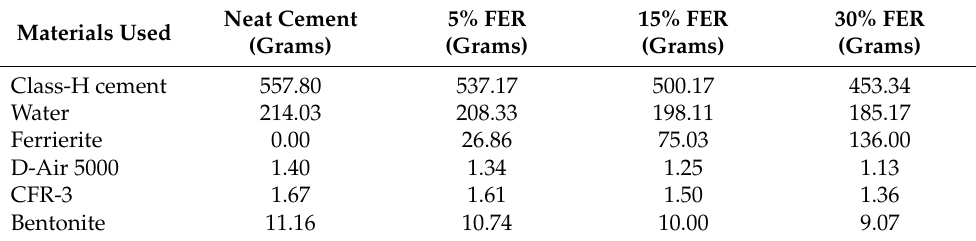
Table 2. Calculated base weights of various components used in the cement mix design for the respective cement formulations. The quantities were scaled up or down in the same proportions depending on the